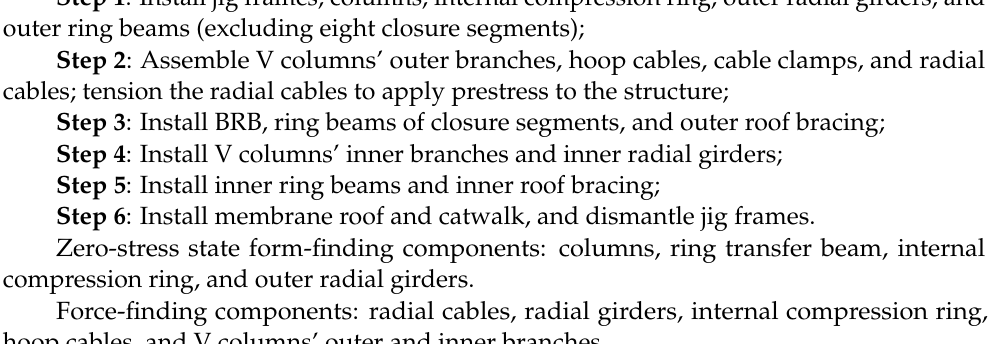
Figure 6. Structural stress in zero-stress state.